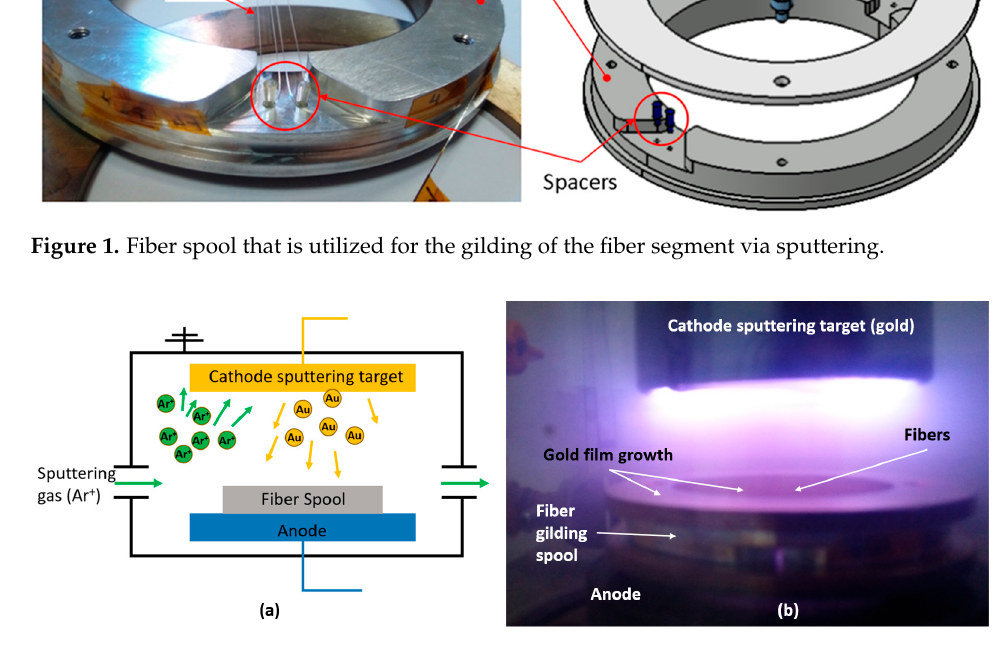
Figure 2. ( a ) Layout and ( b ) experimental picture of the spu tt er vacuum chamber operation.